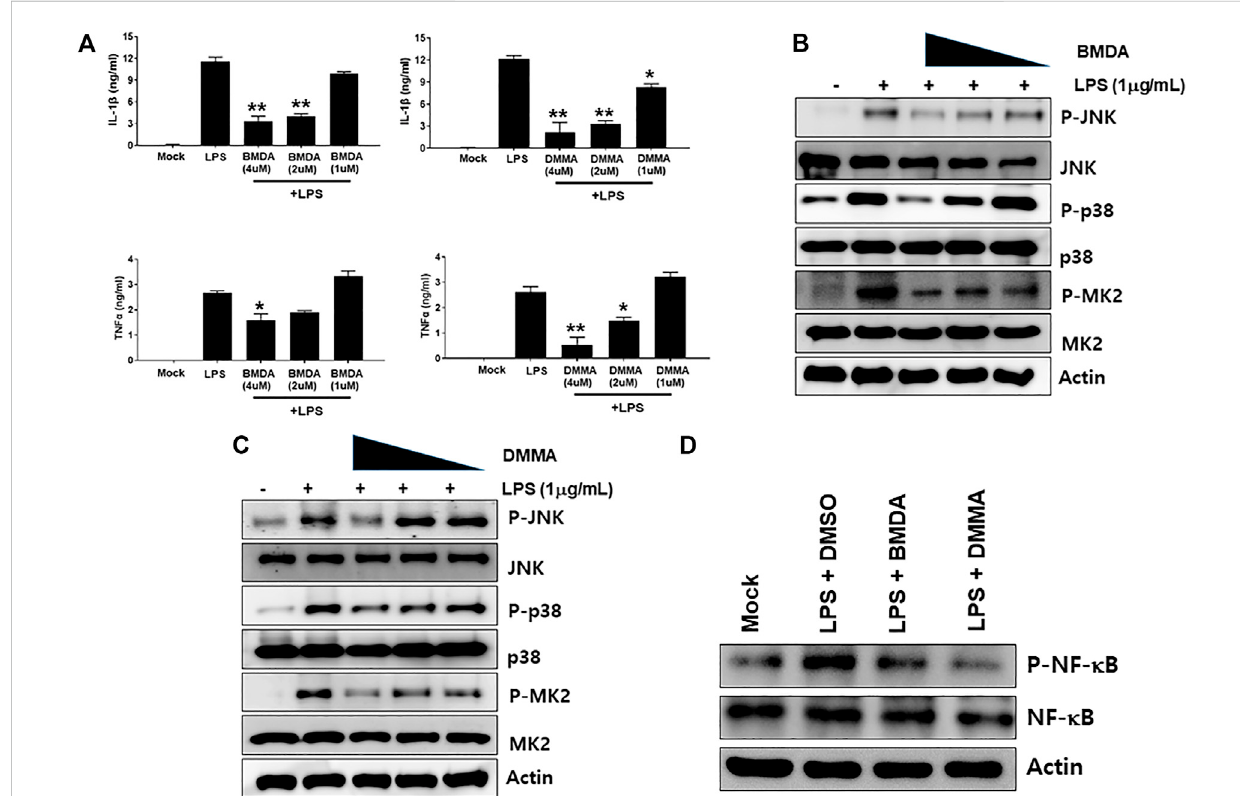
FIGURE 2 BMDAorDMMAinhibitsLPS-inducedin fl ammationthroughdownregulation ofJNK/P38MAPK-MK2 andNF- κ Bsignaling (A) AfterTHP-1cellswere pretreated with BMDA (1, 2, and 4 μ M), DMMA (1, 2, and 4 μ M), or DMSO as a control for 3 h, they were stimulated with LPS (1 μ g mL -1 ). The cells were harvested 4 h post-stimulation and subsequently TNF- α and IL-1 β cytokines were measured by ELISA. [For IL-1 β ELISA, **; p < 0.01, LPS vs . BMDA (2 or 4 μ M)+LPS, LPS vs . DMMA(2 or 4 μ M)+LPS. *; p < 0.05, LPS vs . DMMA (1 μ M)+LPS. For TNF- α ELISA, **; p < 0.01, LPS vs . DMMA (4 μ M)+LPS. *; p